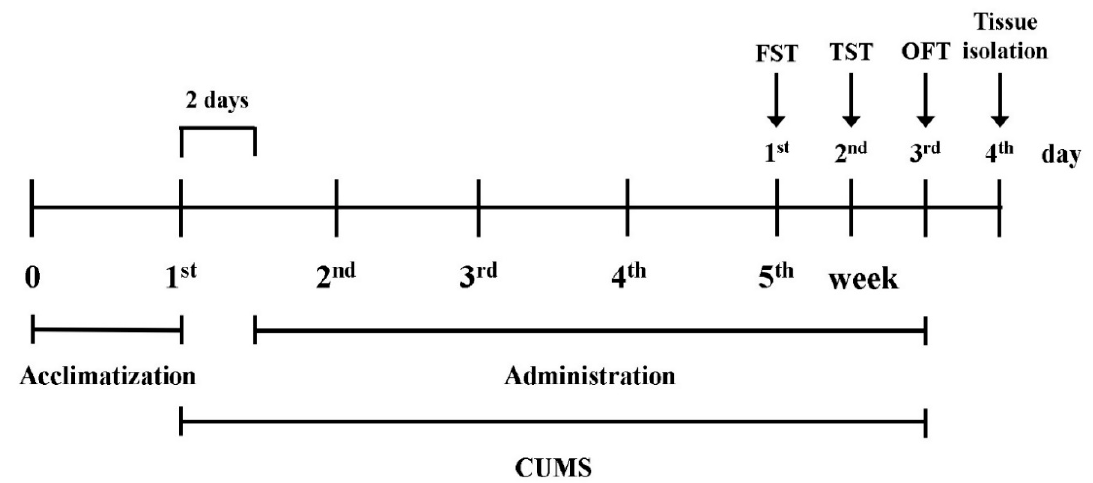
Figure 1. The overall procedure of animal behavioral experiments. FST: forced swimming test; TST: tail-suspension test; OFT: open field test; CUMS: chronic unpredictable mild stress.